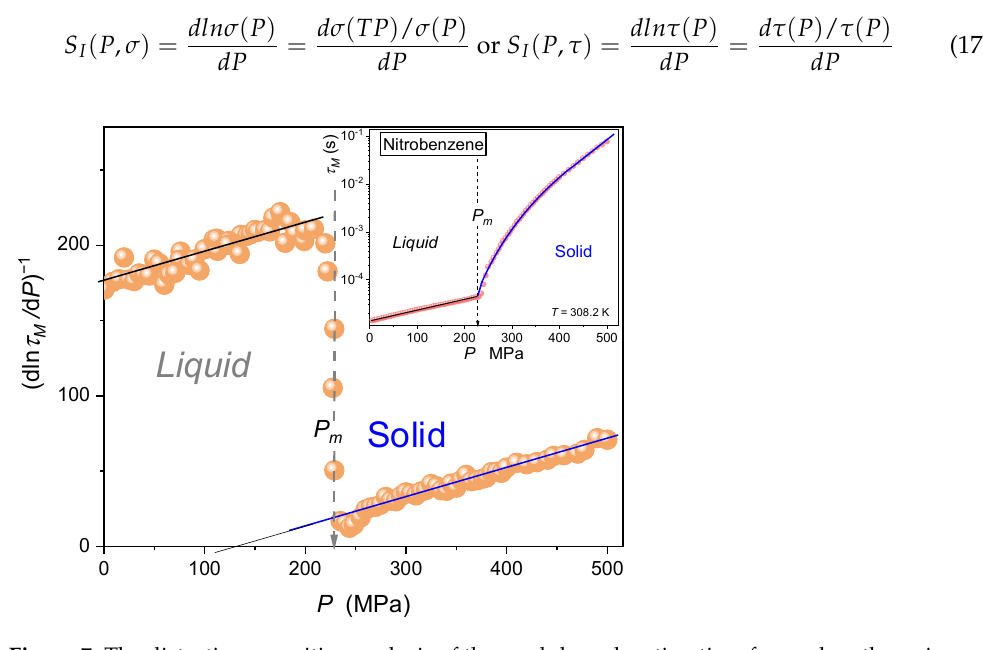
Figure 7. The distortions-sensitive analysis of the modulus relaxation time focused on the universal portrayal via Equation (18), yielding basic parameters for the critical-like description via Equation (19): ψ = 5.4 and P ∗ = 125 MPa (solid), and ψ = 5.0 and P ∗ = − 720 MPa (liquid). Note: the melting pressure P m = 230.6 MPa. The related portrayal of τ M ( P ) experimental data, portrayed by Equation (19), are given in the inset.